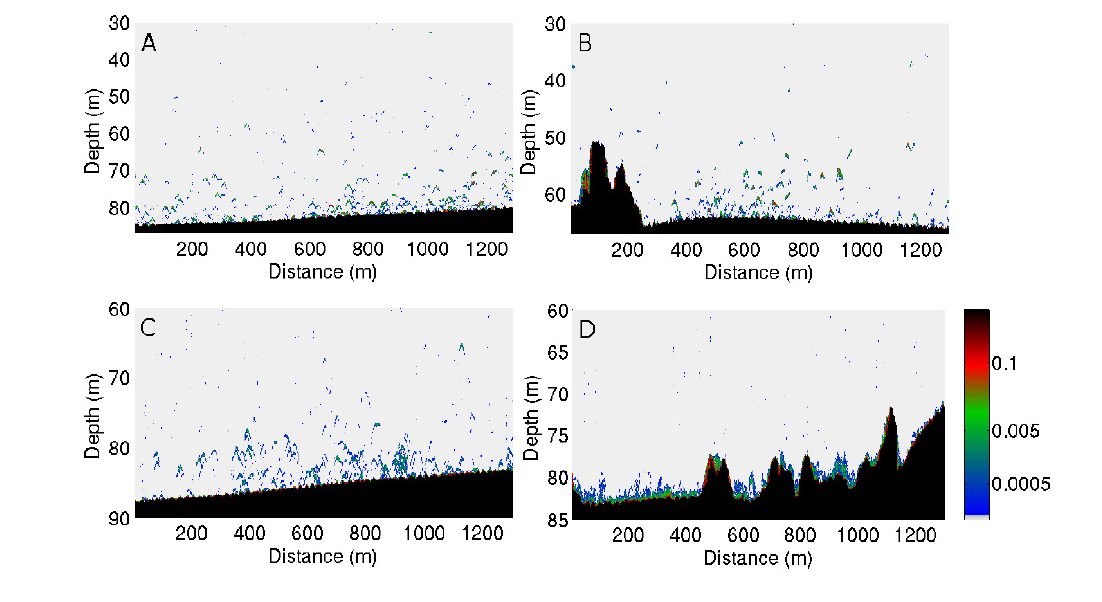
Figure 1. Echograms showing cod aggregations on ( A , B ) 28–29 May and ( C , D ) 18–19 June 2011, off the coasts of Massachusetts and New Hampshire in Ipswich Bay during the same University of New Hampshire surveys described in [32,33]. The color bar shows the volume density in the number of cod/m 3 . Black regions represent seafloor